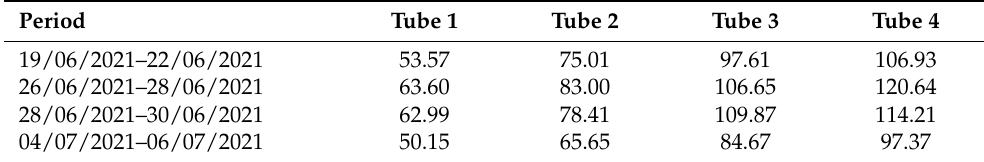
Table 5. Air flow rate in m 3 /h for each tube and each experimental period.